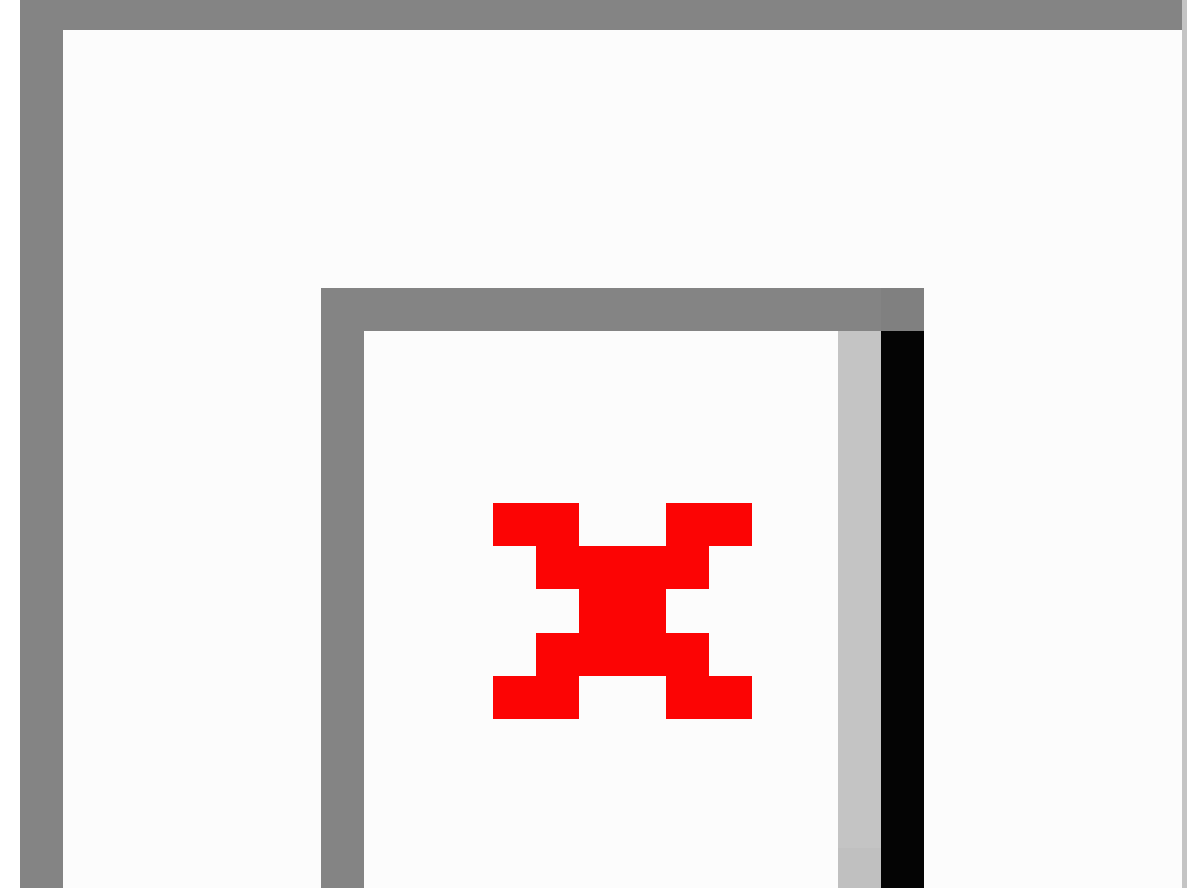
Figure 2. The graph showing step goals and number of steps achieved each week and the step goal for the following week along with a motivational